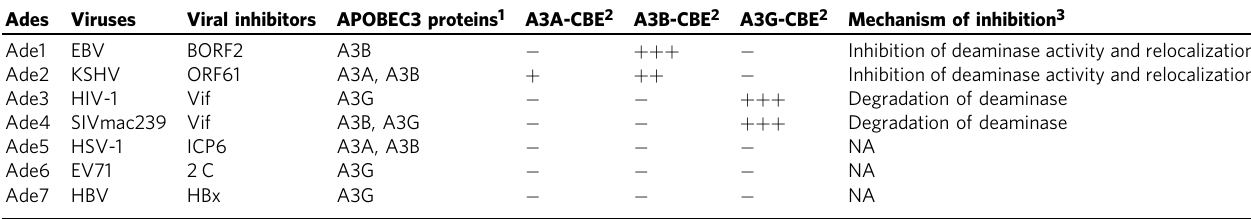
Table 1 Summary of characteristics of the anti-deaminases (Ades) used in this study. Ades